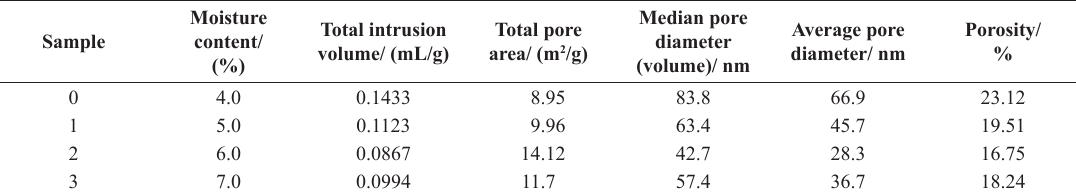
Tab.6 Pore parameters of cement stabilized graded stones with different moisture contents